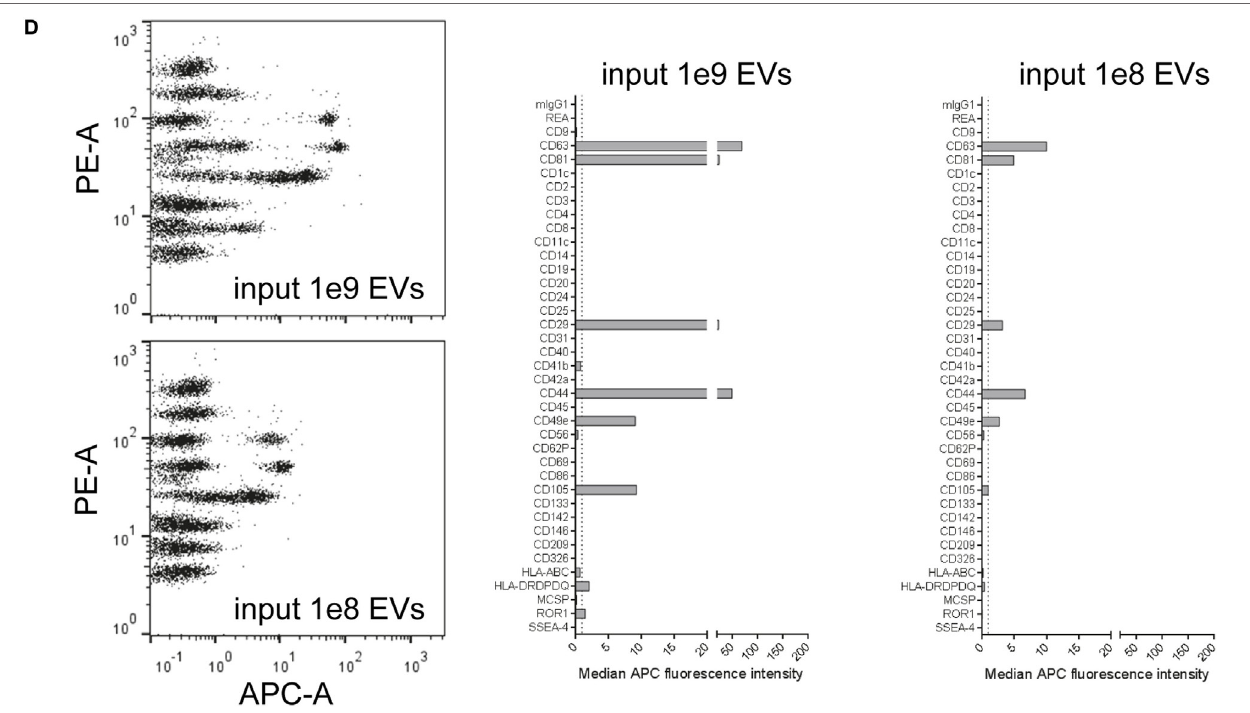
FigUre 9 | Detection of injected human extracellular vesicles (EVs) in mouse plasma. (a) Female NMRI mice were injected intravenously at doses of 2 × 10 11 human mesenchymal stromal cell line-EVs/mouse. Blood was collected 1 or 30 min post injection by heart puncture. Plasma from two to three mice for each time point was analyzed in the multiplex flow-cytometry assay by using a pan tetraspanin mix of CD9/CD63/CD81-APC antibodies. (B) Representative dot plots and (c) quantification of detected bead populations from analyzed plasma samples from both time points compared to a plasma sample from a non-injected mouse. (D) The same EV preparation was analyzed directly at assay input doses of 10 9 and 10 8 EVs for comparison. See Figure S13 and Table S2 in Supplementary Material for further